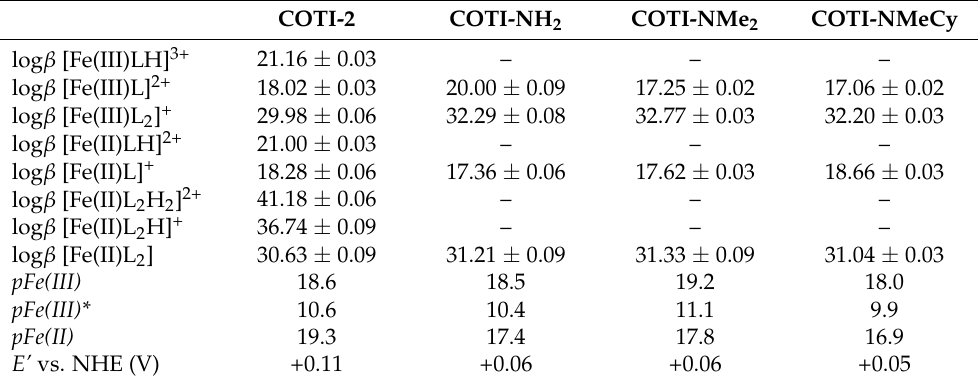
Table 2. Overall stability constants (log β ) of the iron(III/II) complexes and formal redox potentials ( E ’) of the iron(III) ‒ ligand (1:2) systems.